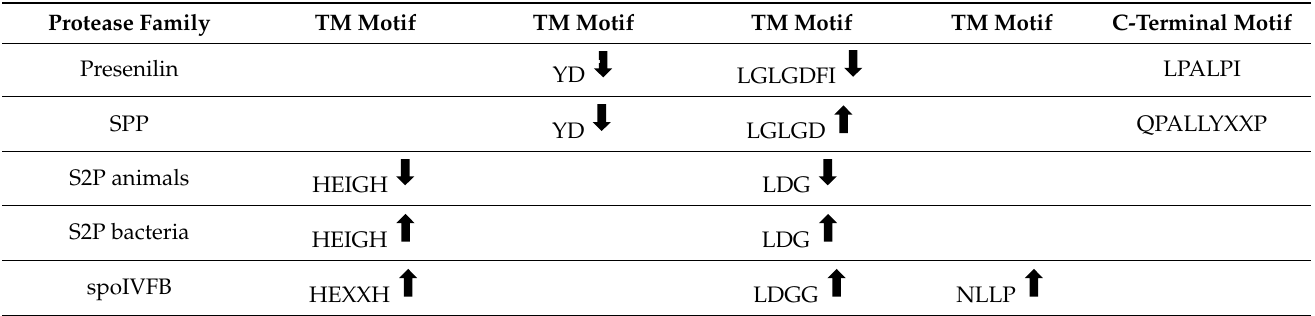
motifs although they do not have the HEXXH motif. Interestingly, these proteases also contain a motif in their C-terminal region which has similarities to the CPALLY motif in